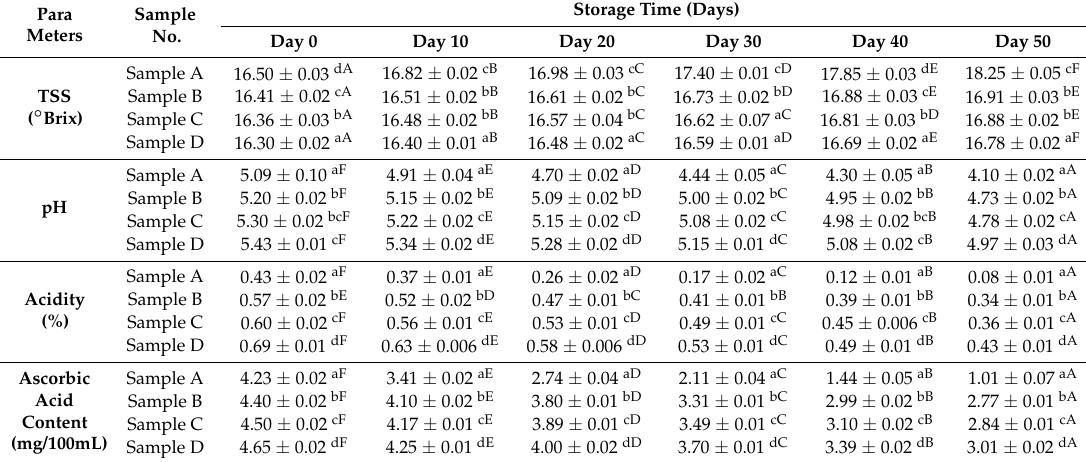
Table A1. Evaluation of physicochemical parameters of treated wood apple beverage samples during storage.